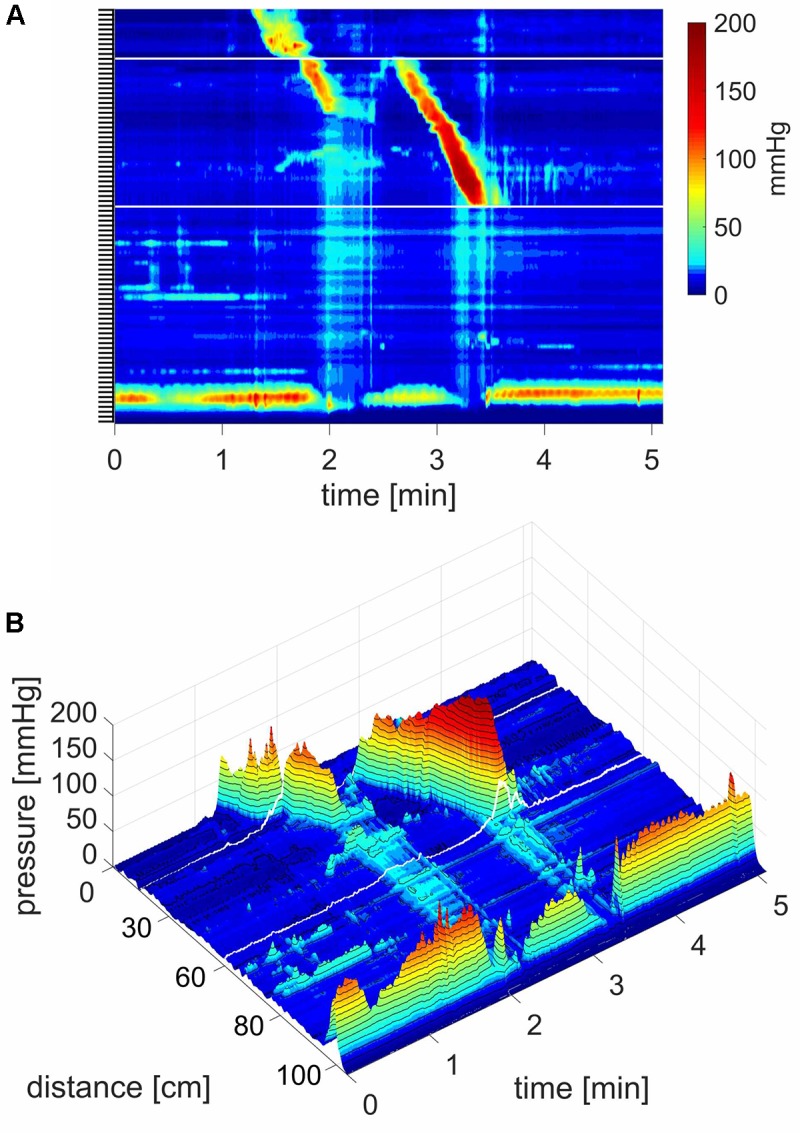
Two proximal High Amplitude Pressure Waves (HAPWs) that develop into SPWs: HAPW-SPWs in response to a meal. (A) HAPWs that turn into SPWs with full anal sphincter relaxation. The image shows activity in 100 cm of the colon (position of 84 sensors are shown at the left side of the figure). The activity was observed 12 min after meal intake. The first HAPW-SPW was associated with liquid outflow, the second with liquid and gas expulsion. (B) 3D representation of (A).